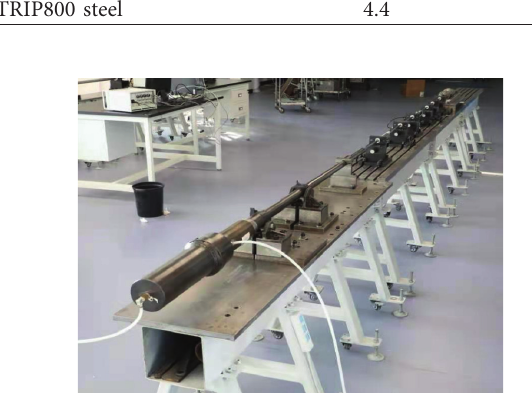
Figure 2: Split Hopkinson pressure bar.